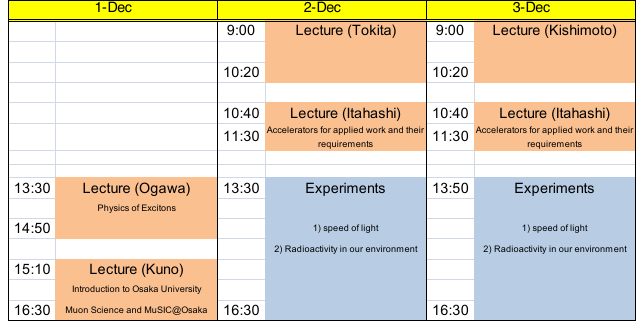
Fig. 2. Schedule of DaNang school in 2011